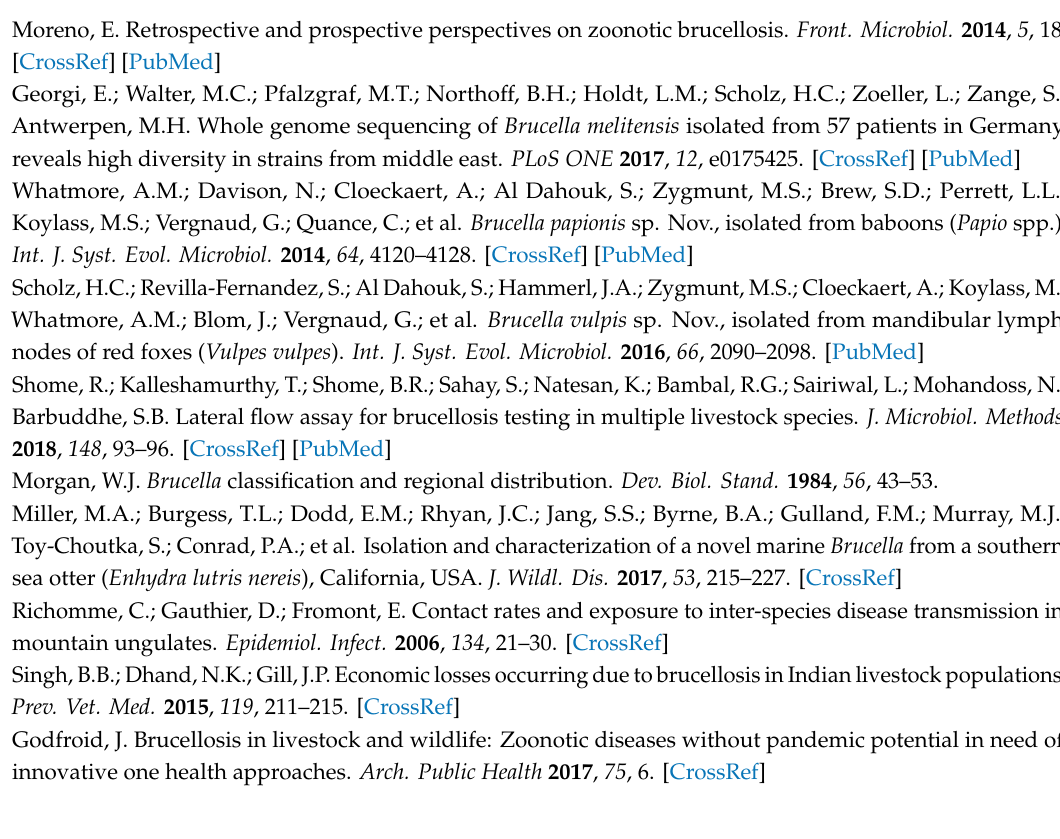
Table S1: List of primers and primer sequences used for detection of antimicrobial associated resistance